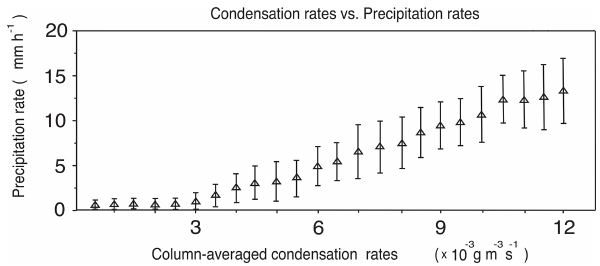
Figure 13. Mean precipitation rates corresponding to each column- averaged condensation rate for the period between 14:00 and 17:20LST in the control-b run. One standard deviation of precip- itation rates is represented by a vertical bar at each condensation